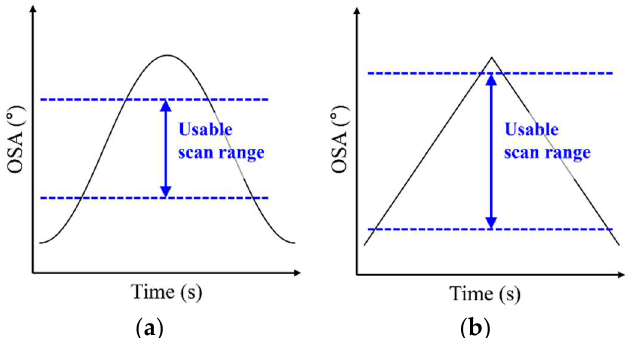
Figure 1. Definition of usable scan ranges (USRs) of the optical scan angle (OSA) for different waveforms: ( a ) sinusoidal and ( b ) triangular.